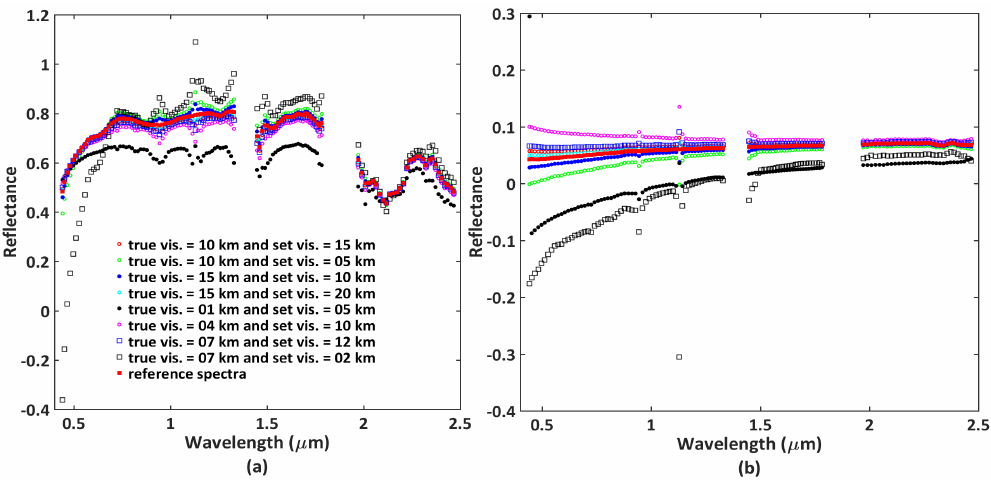
Figure 20. Effects of scattering, variation in visibility, and surface albedo on spectral qualities (of a randomly selected pixel) used to generate the bright ( a ) and dark ( b )